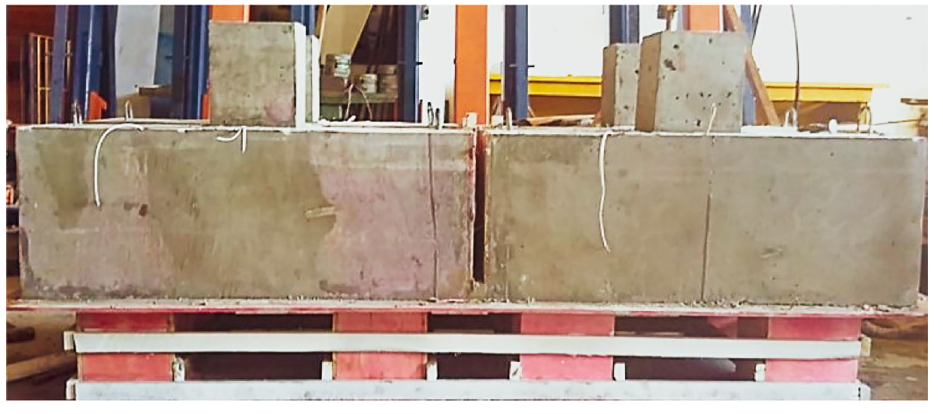
Figure 7. Pile cap